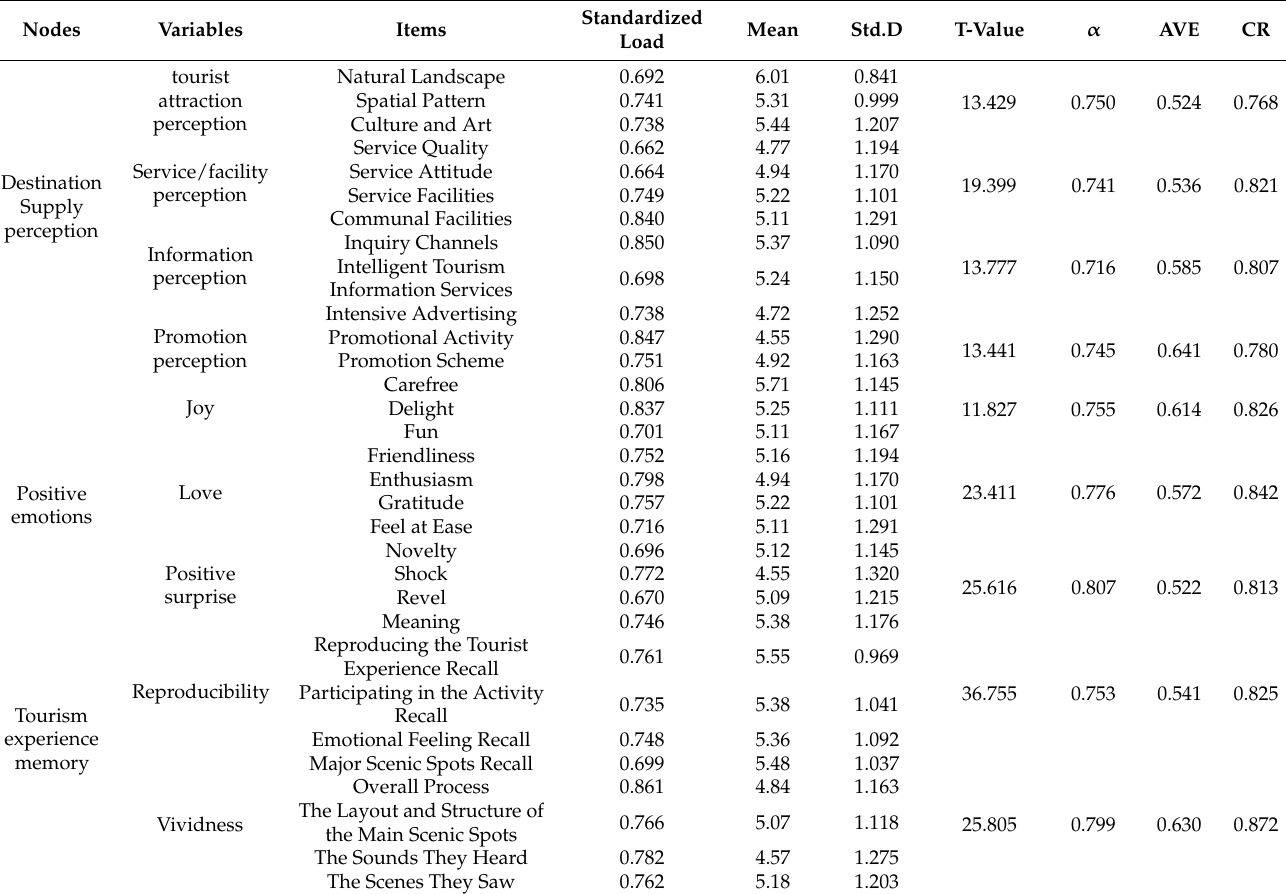
Table 2. Reliability analysis results.